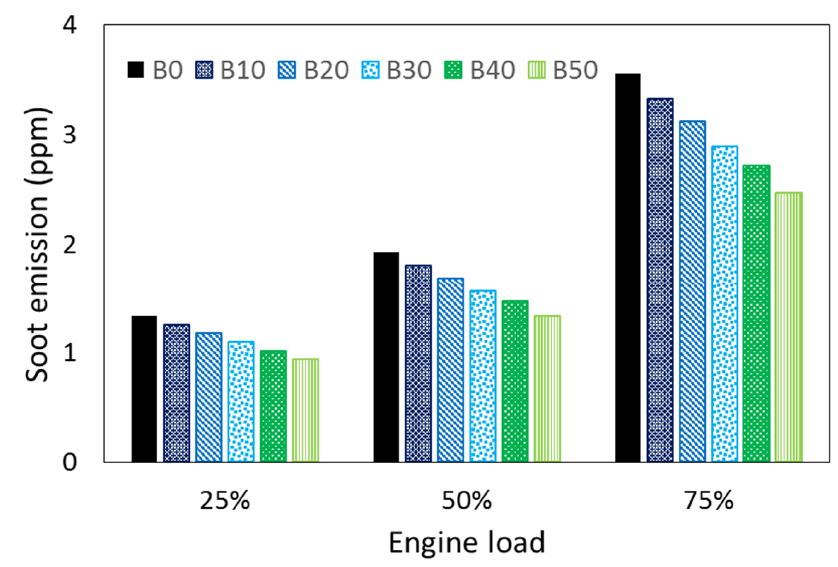
Figure 12. Effect of biodiesel on NOx emission.